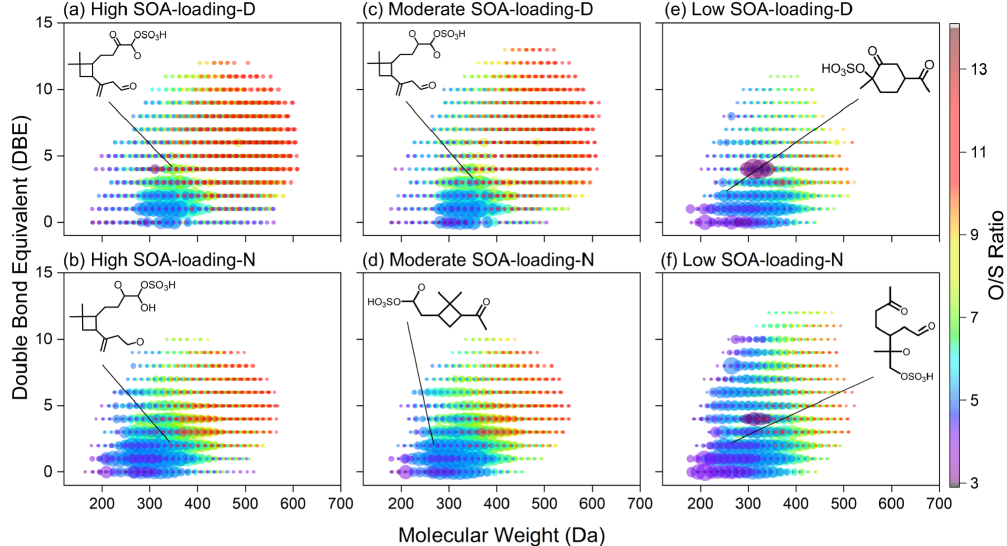
Figure 8. DBE versus molecular weight of CHOS compounds. The color bar and marker size denote the O / S ratios and the relative peak magnitudes of CHOS compounds. The formulae for biogenic SOA compounds with relatively high intensity were C 15 H 24 O 7 S, C 15 H 28 O 7